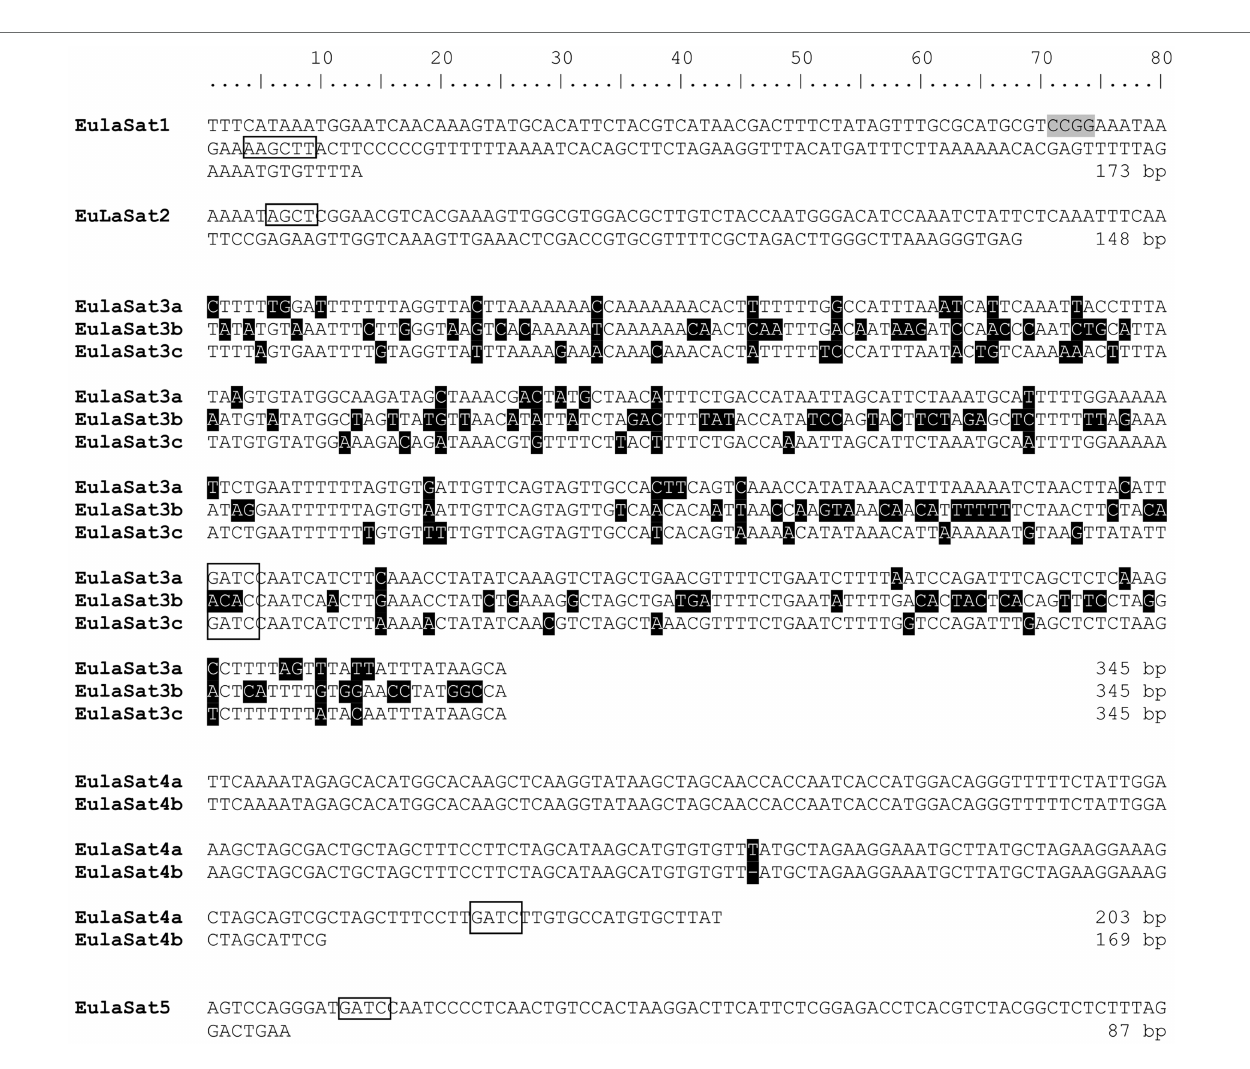
FIGURE 2 | Consensus sequences and subunit structure of the tandem repeat monomers. The monomer consensus sequences of the EulaSat1 to EulaSat5 satellite DNAs are shown. Recognition sites of restriction enzymes used to release the DNA ladder ( Figures 3, 5 ) are indicated by rectangles. Hpa II/ Msp I recognition sites are shaded in gray. EulaSat3 and EulaSat4 are divided into the EulaSat3a, EulaSat3b, and EulaSat3c as well as the EulaSat4a and EulaSat4b subfamilies. These sequences are represented as multiple sequence alignment, with ambiguities shaded in